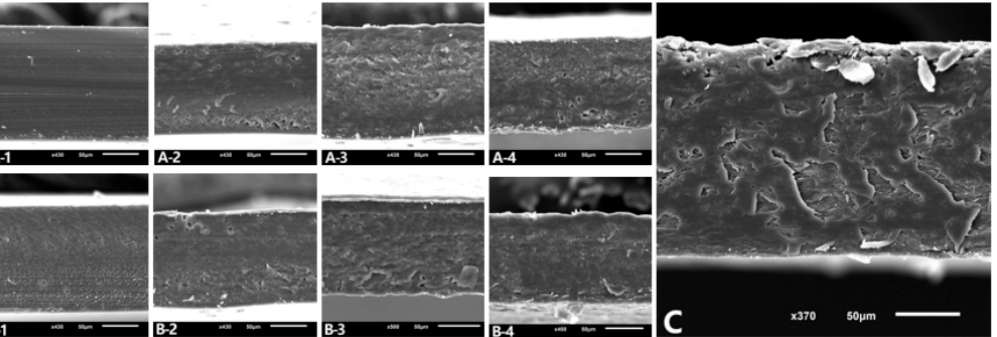
Figure 3. SEM images of the cross-section of the films. Scale bars correspond to 50 µm. ( A-1 ) FA100, ( A-2 ) FA90FC10, ( A-3 ) FA70FC30, ( A-4 ) FA50FC50, ( B-1 ) FL100, ( B-2 ) FL90FC10, ( B-3 ) FL70FC30, ( B-4 ) FL50FC50, and ( C ) FC100. FA refers to acidified plasma protein, FL to lyophilized plasma protein, and FC to NFC. The number refers to the percentage of each component added to prepare the film.